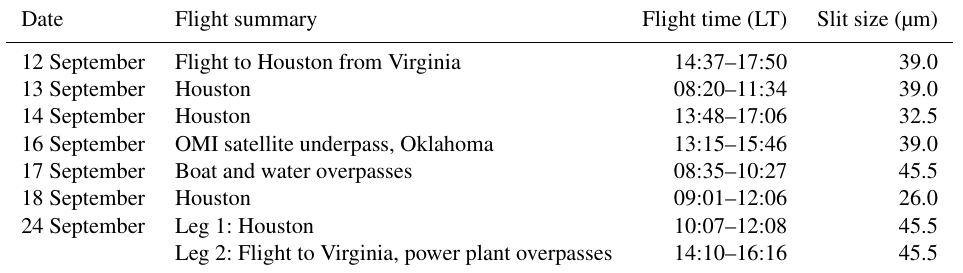
Table 2. Summary of GeoTASO flights during Discover-AQ Texas 2013. LT = UTC − 4h for 12 September and LT = UTC − 5h for other days.